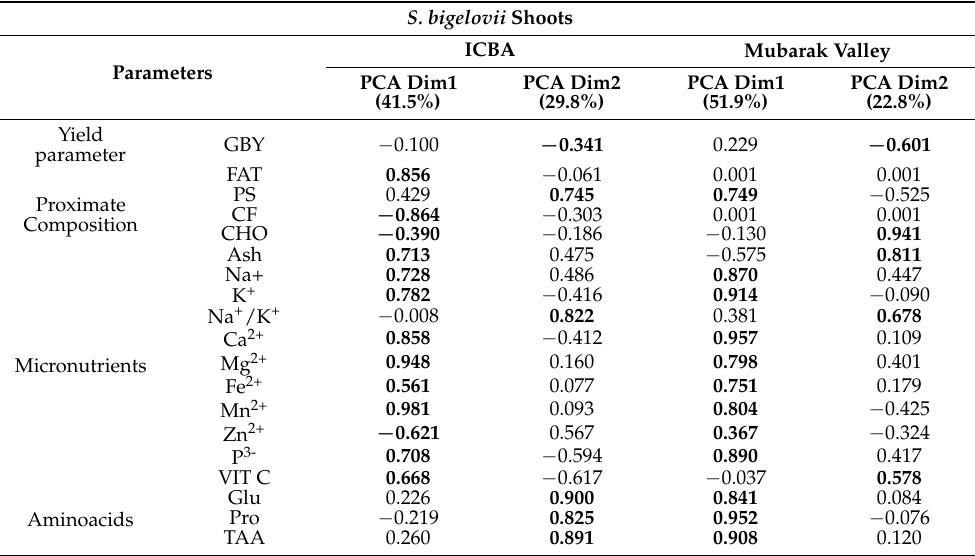
Table A7. Eigenvector values per Principal Component Analysis (PCA) Dimension 1 and 2 (Dim1 and Dim2) for the green biomass yield, proximate composition, micronutrients and amino acids measured for the shoots of six S. bigelovii genotypes at the vegetative stage at ICBA’s experimental station in the United Arab Emirates (Figure 4a) and Mubarak Valley in Egypt (Figure 4b). The higher value for each parameter between the two axes is in bold.